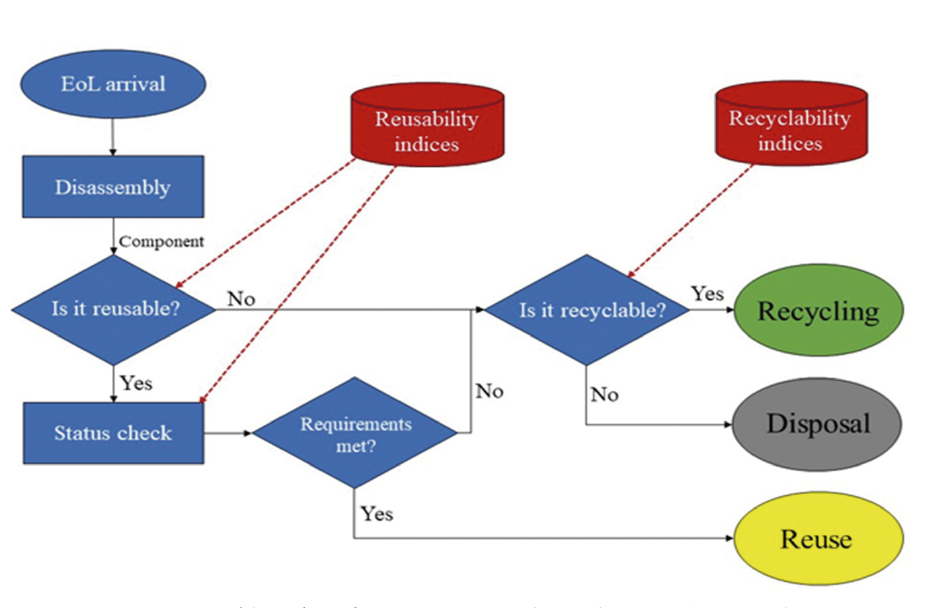
Figure 3. Disassembly and verification process at the workstation (Sergio et al.,